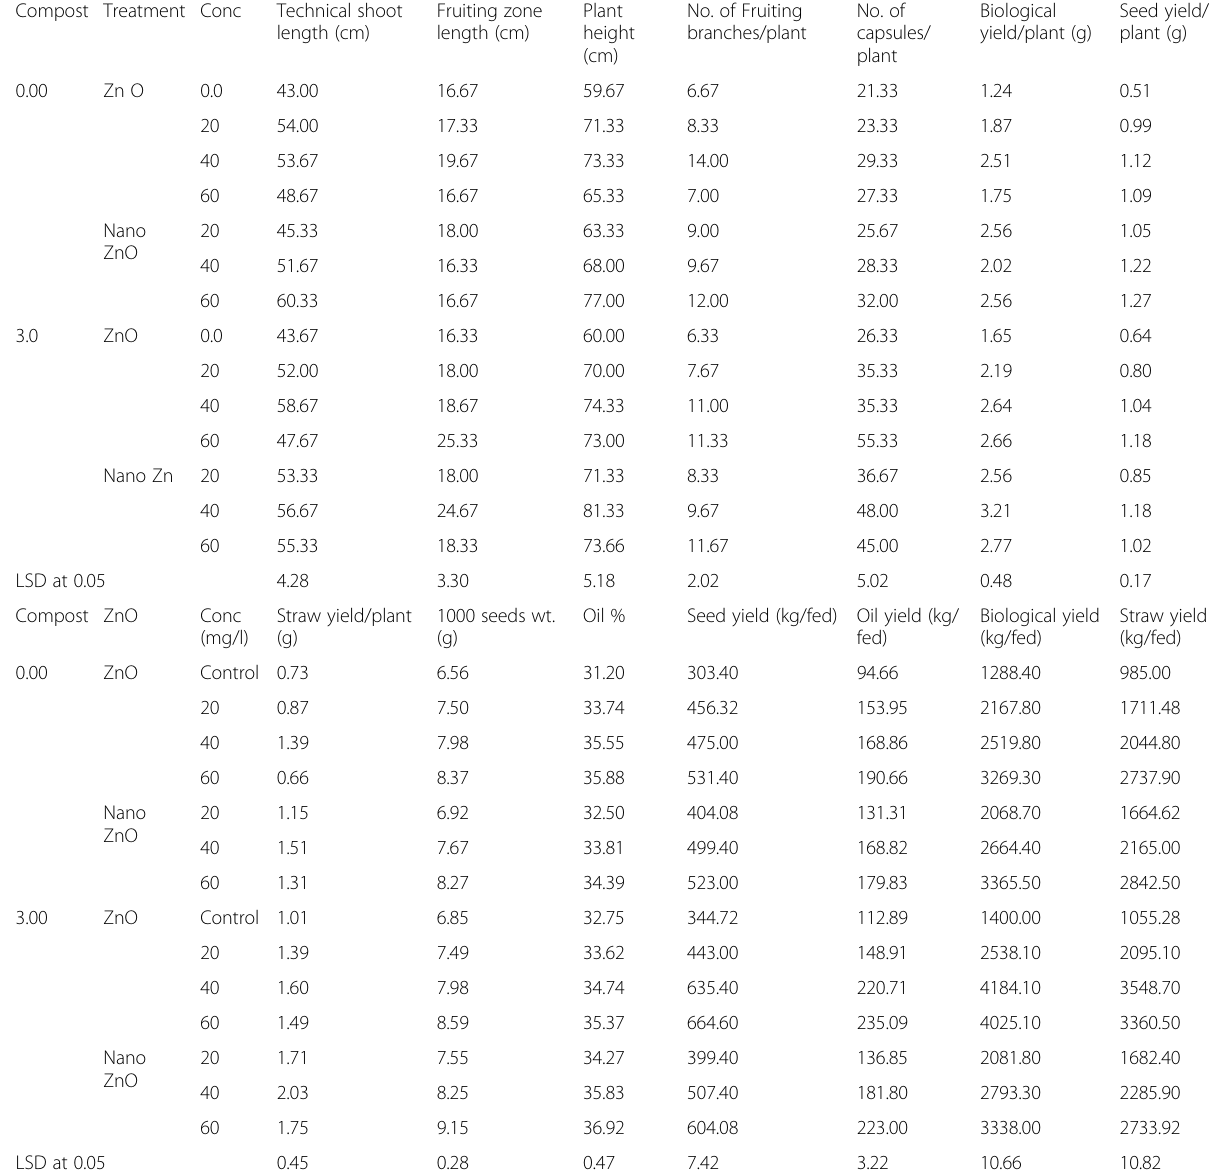
Table 7 Effect of interaction of compost and/or ZnO and nano ZnO different concentrations (0, 20, 40, and 60 mg/l) on yield and yield components of flax plant under sandy soil (data are means of two seasons) Compost Treatment Conc 0.00